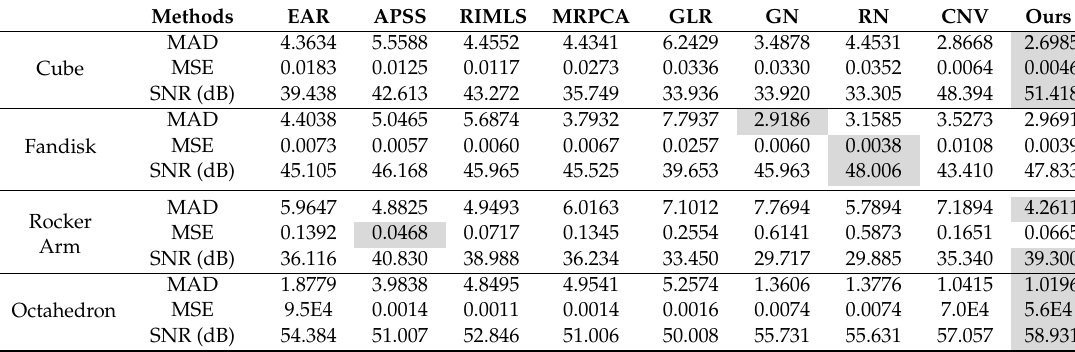
Table 2. Error metrics by comparative methods for each one of the 3D objects.